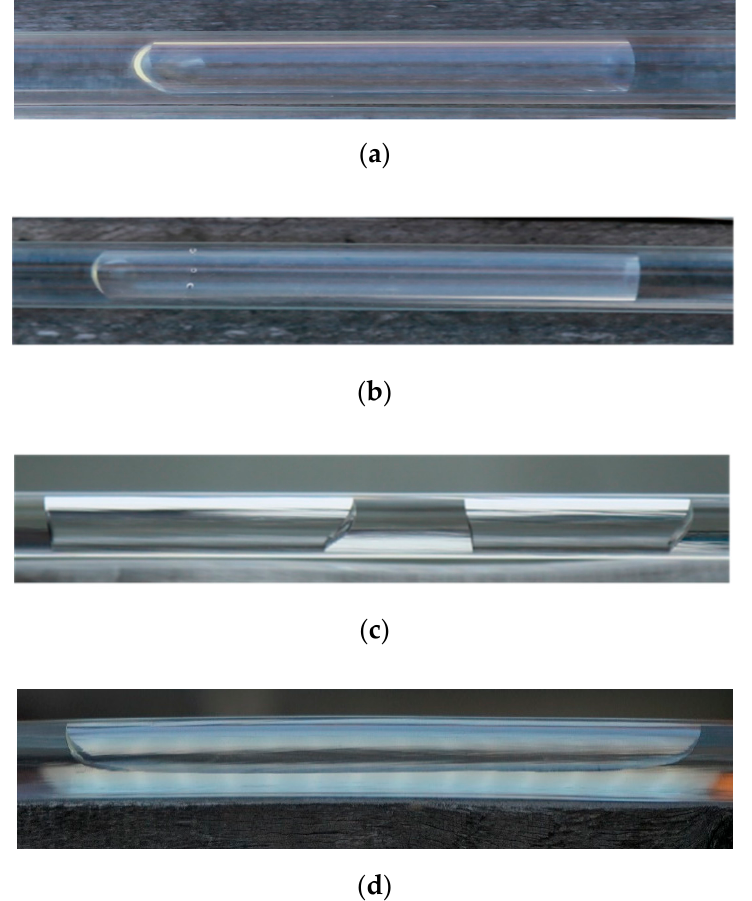
Figure 5. Bubble pattern in the siphon tubes: ( a ) D-3–4; ( b ) D-5; ( c ) D-6.5; ( d ) D-8. A sudden acceleration of the fluid can be observed at the junction of the horizontal and vertical descending section: the bubble deformation elongates, and the shape becomes irregular. However, this process lasts only for a short period, and the flow pattern of the vertical section soon returns to the same as that of the horizontal section. The bubbles may merge during the motion but not redissolve in the water. Eventually, the siphon flow will still be discharged from the siphon tube as a gas-liquid two-phase flow.